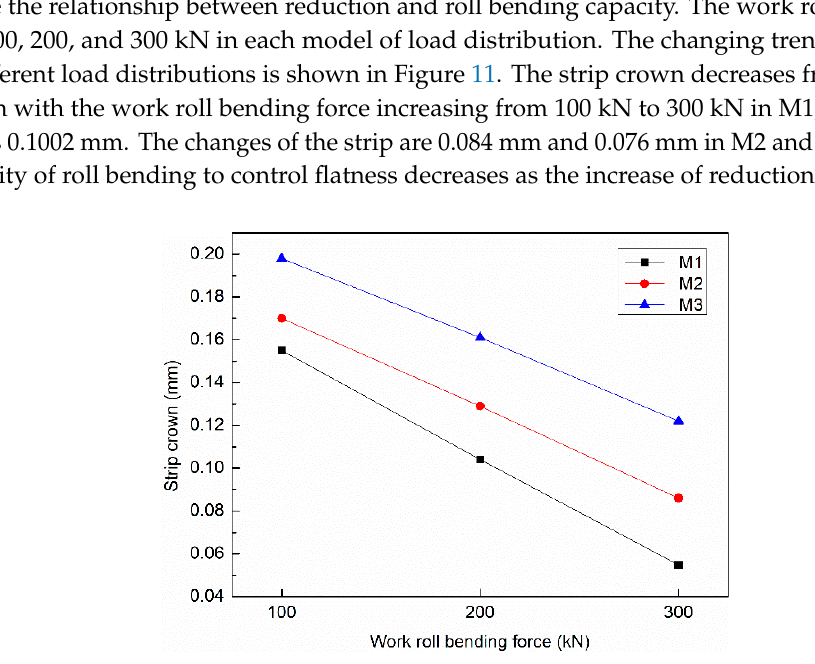
( b ) Figure 10. The ( a ) flatness and ( b ) thickness profile of S4 under different load distribution. The profile of the roll gap during the cold rolling process can be described as the Equation (27).